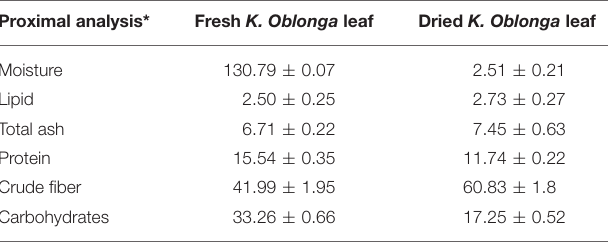
TABLE 3 | Proximal analysis of fresh Kageneckia oblonga “Bollén” leaves and microwave-assisted convective dried (MWFC 1,120 W/20 ◦ C). Proximal